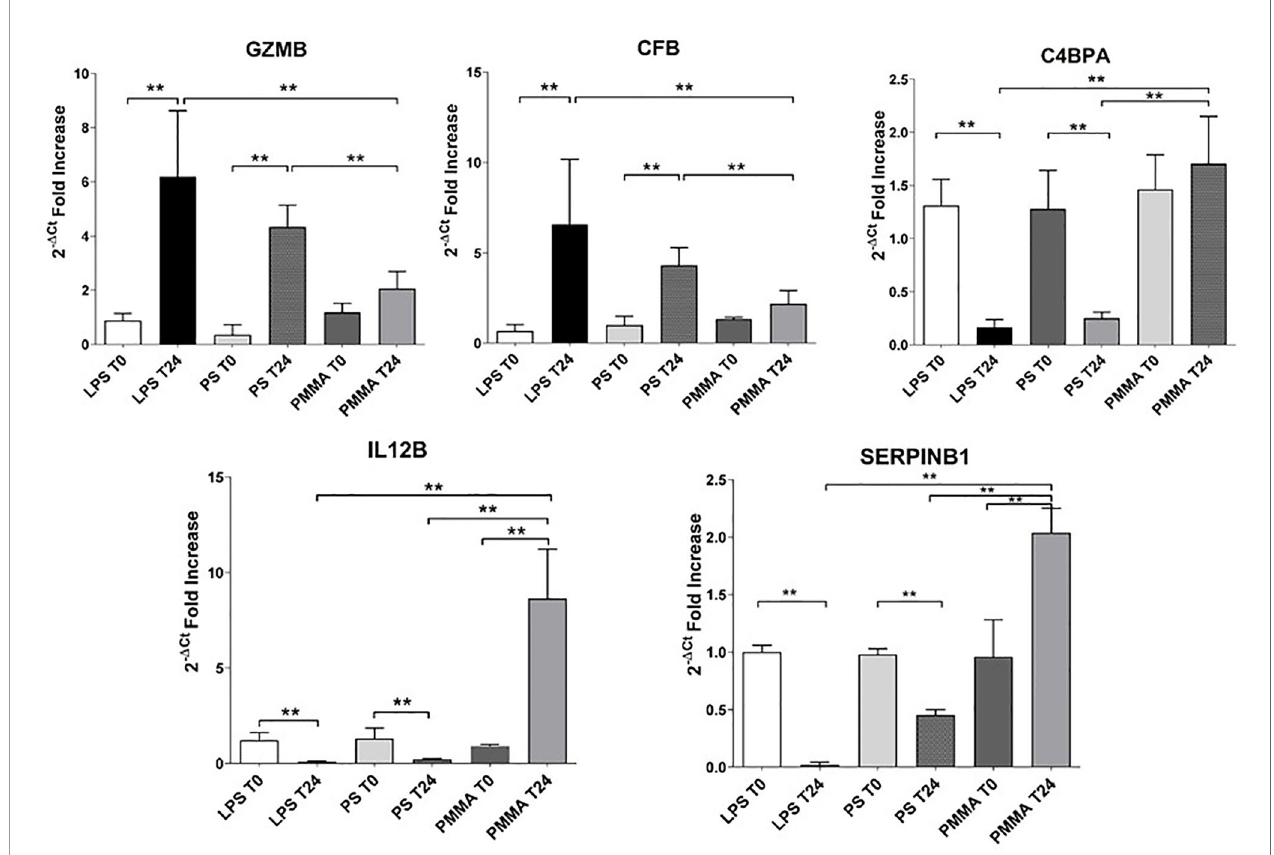
FIGURE 7 | Validation of targeted genes. Real-time PCR of six genes (GZMB, CFB, C4BPA, and SERPINB1) differentially expressed in PBMC of LPS T0, LPS T24, PMMA T0, PMMA T24, PS T0, and PS T24 groups. Data are expressed as mean ± SD; ** p <